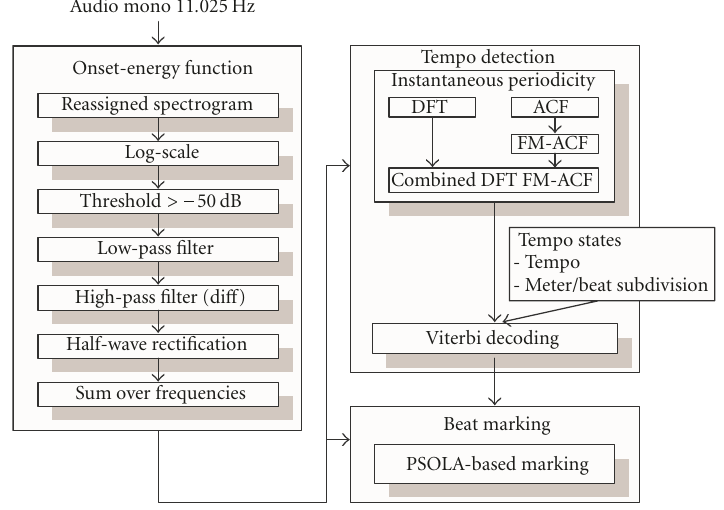
Figure 1: Flowchart of our system for tempo, meter estimation, and beat